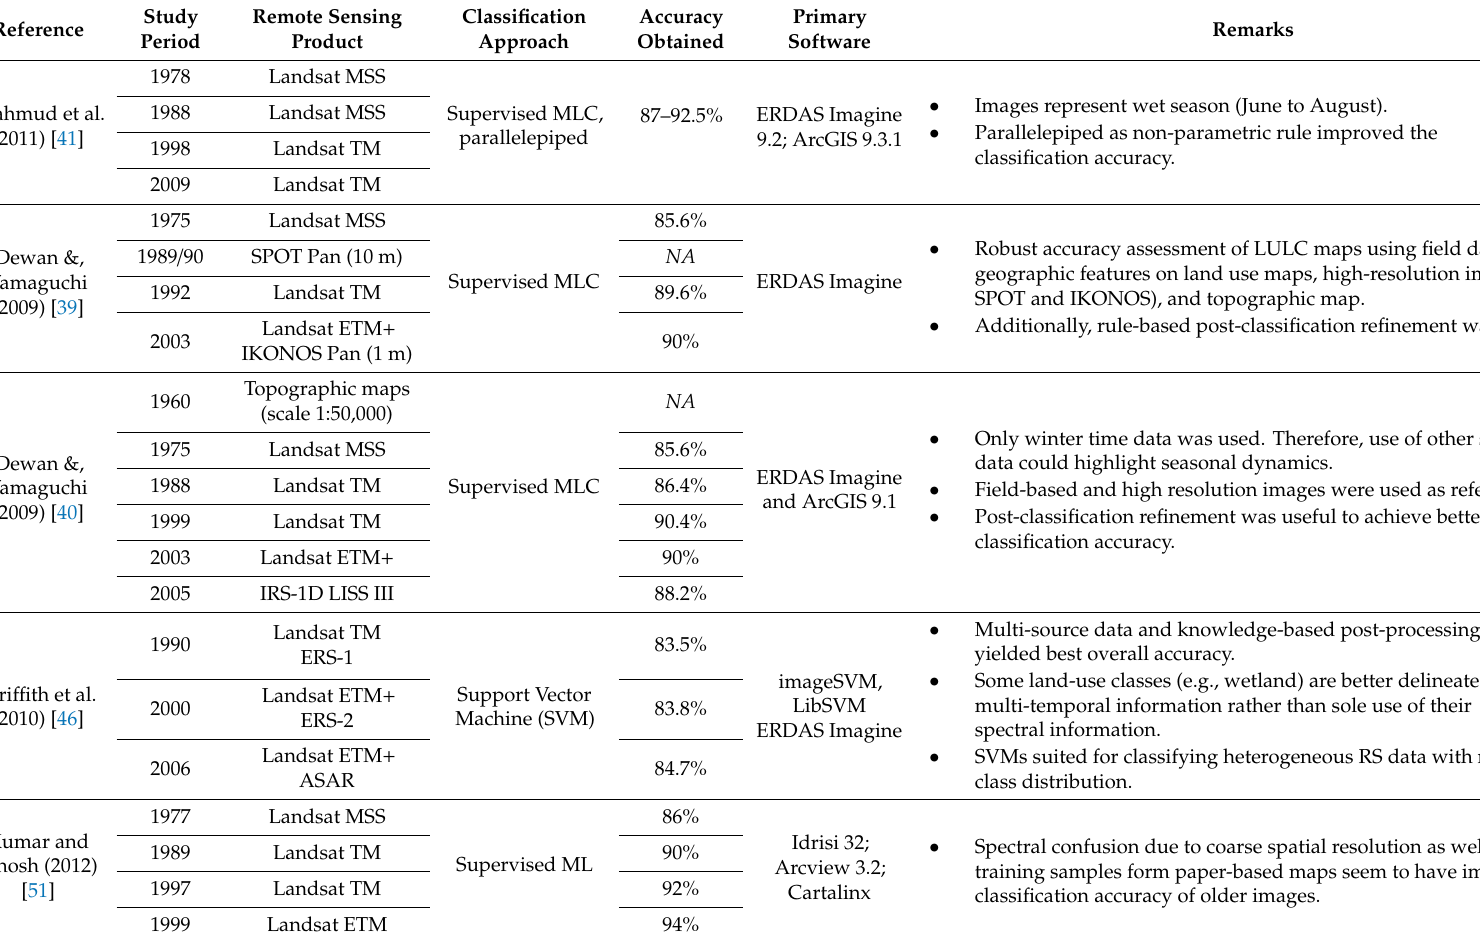
Table A3. Details of the wetland related studies based on remote sensing data and